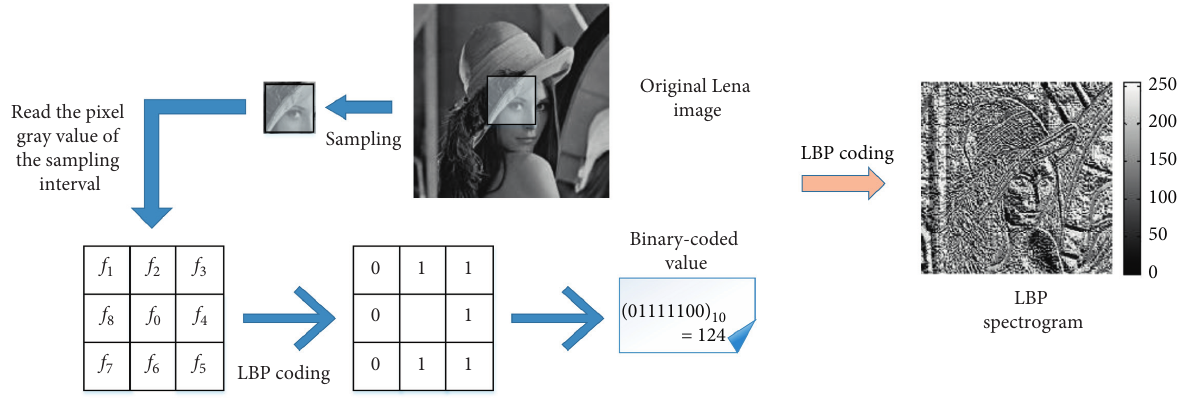
Figure 1: Schematic diagram of LBP operator coding